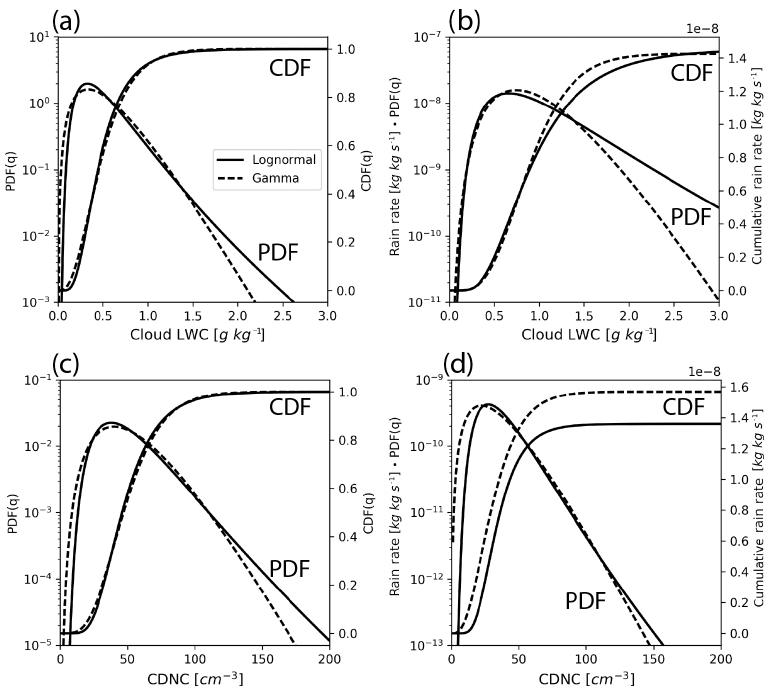
Figure 1. (a) The probability density function (PDF) and cumulative distribution function (CDF) of cloud LWC ( q c ) that follow the gamma (dashed) and lognormal (solid) distribution. For the both distributions, (cid:104) q c (cid:105) = 0 . 5gkg − 1 and v q = 3 . 0. (b) The PDF and CDF of autoconver- sion rate computed based on the KK2000 scheme in Eq. (15) and the PDF of q c . In the computation, the N c is kept at a constant of 50cm − 1 . (c) The PDF and CDF of N c that follow the gamma (dashed) and lognormal (solid) distribution. For the both distributions, (cid:104) N c (cid:105) = 50cm − 3 and v N = 5 . 0. (d) The PDF and CDF of the autoconversion rate computed based on the KK2000 scheme in Eq. (15) and the PDF of N c . The q c is kept at 0.5gkg − 1 in the computation.